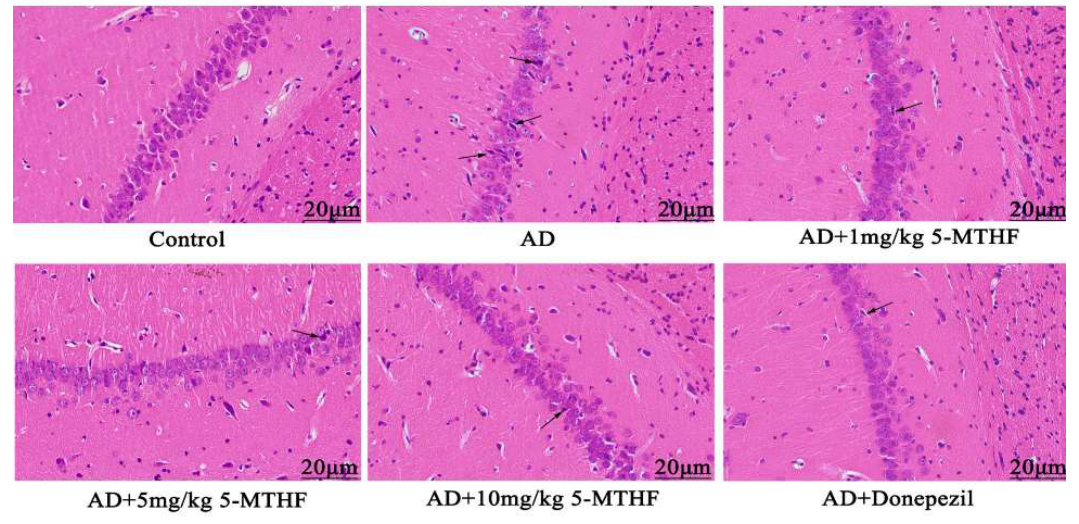
Figure 5. Typical HE staining images of the hippocampal CA1 region (magnification 400×). Atro- phied neurons are indicated by arrows.